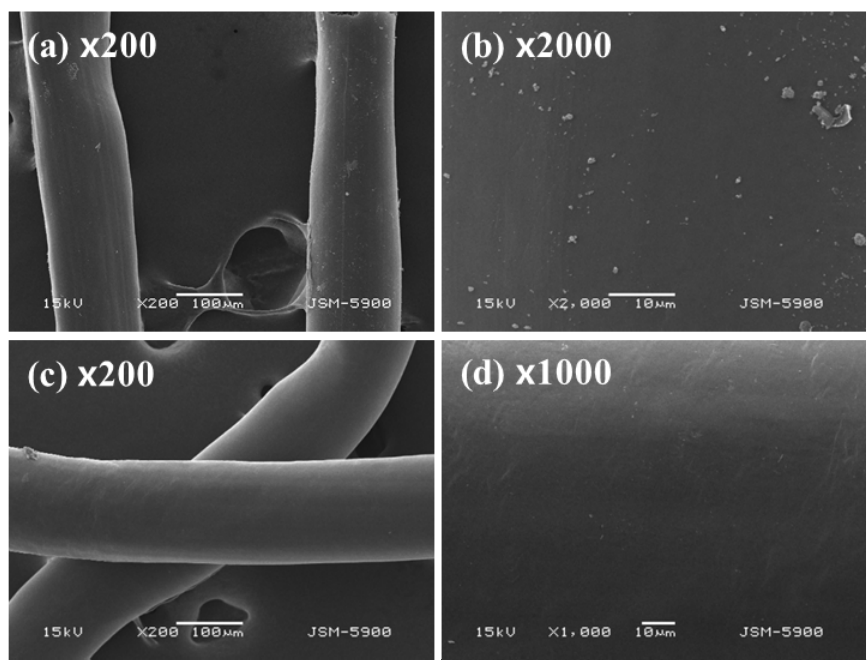
Figure 3. Scanning electron microscopy (SEM) images of ( a ) PAN fiber ×200 magnification, ( b ) PAN fiber ×2000 magnification, ( c ) PAN–oxime fiber ×200 magnification, and ( d ) PAN–oxime fiber ×1000